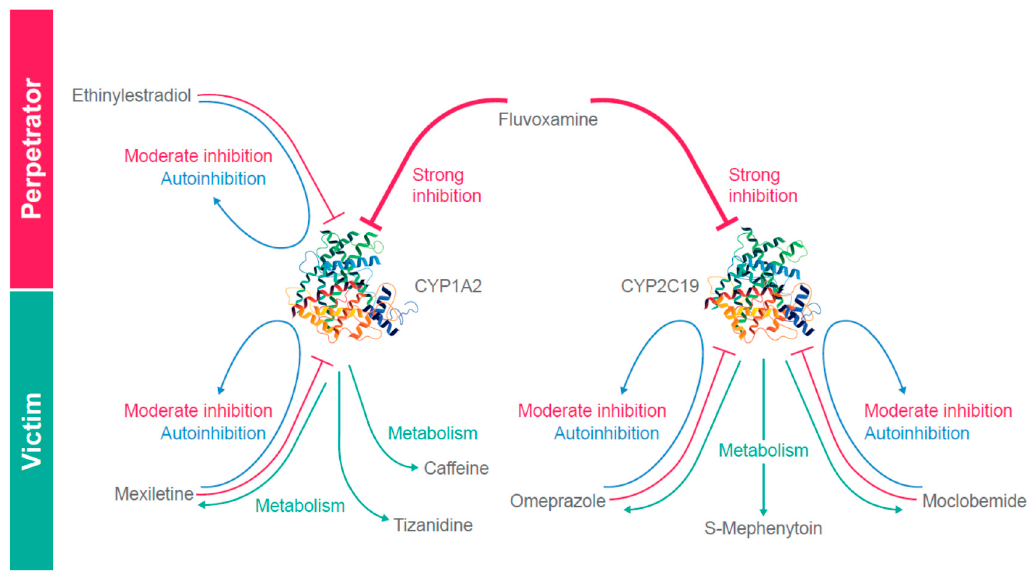
Figure 1. Graphical representation of the CYP2C19/CYP1A2 DDI network. Table 1. Drug–drug interaction (DDI) studies predicted and used for qualification of the network. Strong CYP2C19